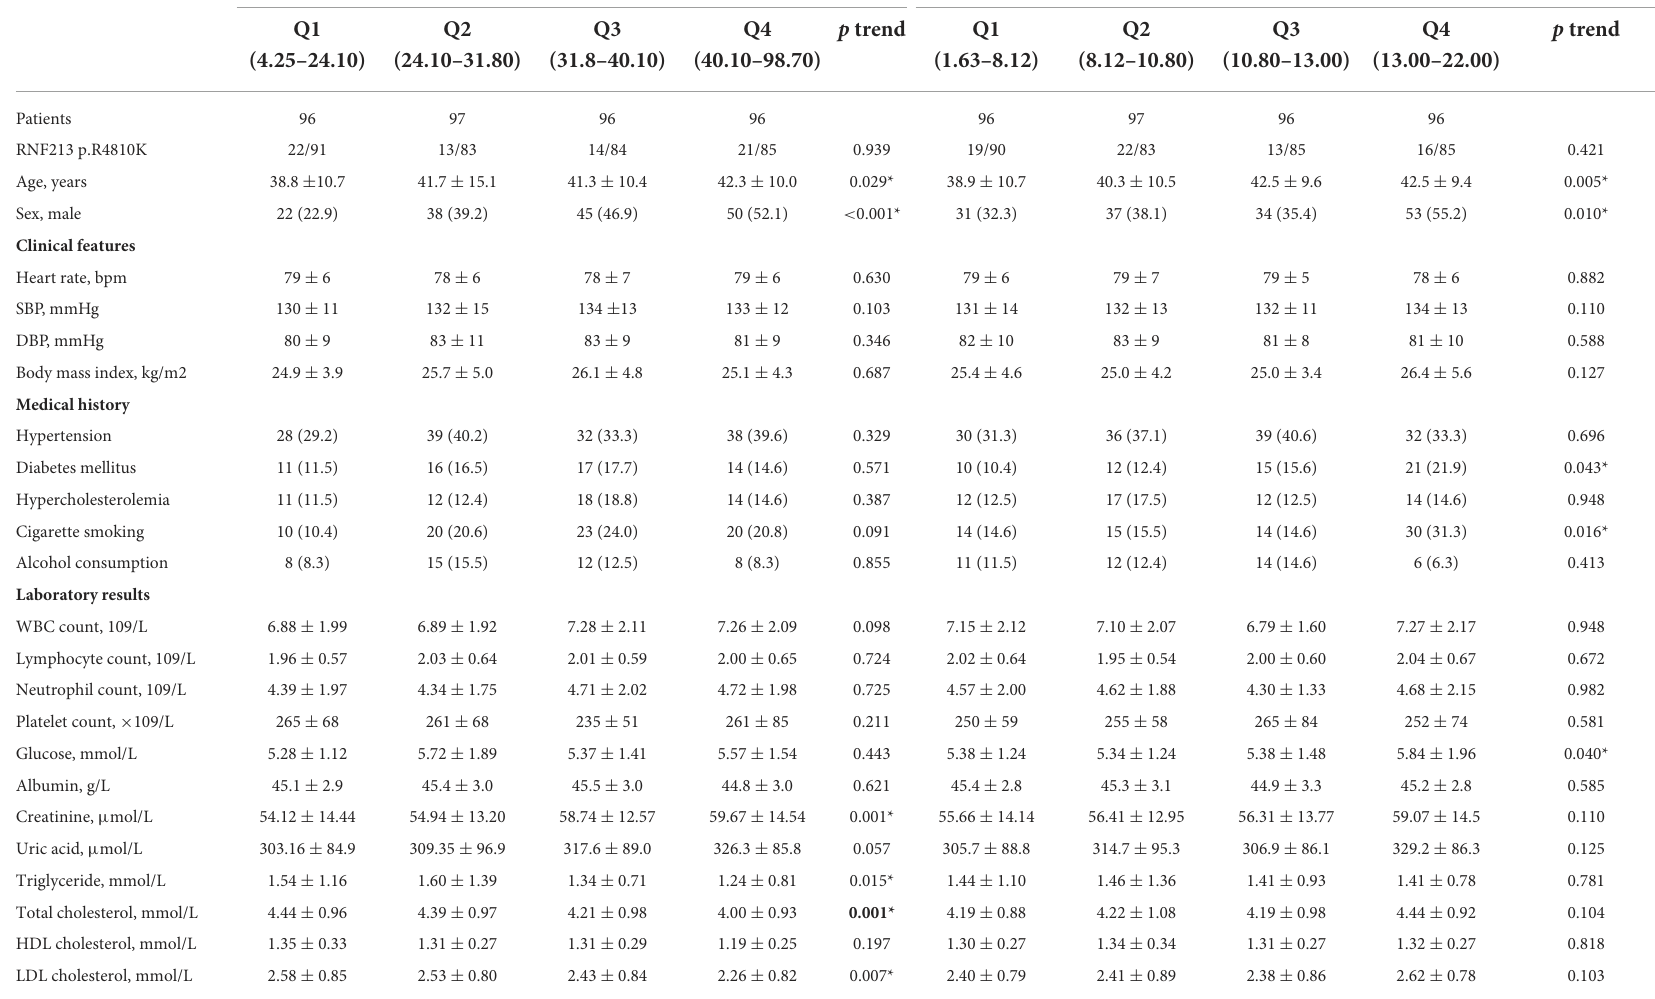
TABLE 2 Baseline characteristics of patients with moyamoya disease (MMD) according to quartiles of serum choline pathway nutrients.